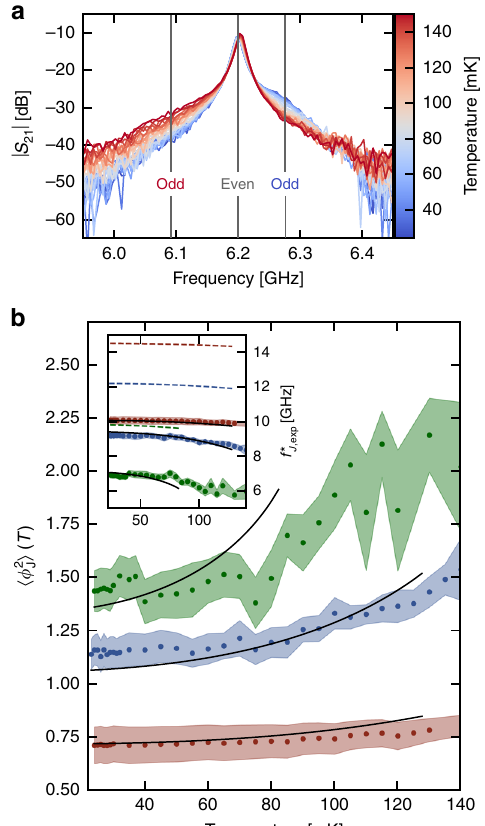
Fig. 3 Temperature-induced renormalization. a Zoom on a even – odd pair of transmission peaks for sample A at temperature ranging from 23 to 150 mK. The even mode (gray) does not move while the odd mode (blue is at 25 mK, red at 130 mK) shifts down in frequency when warming up, showing a downward renormalization of the junction frequency ω (cid:5) . b ZPF of the J i as a function of the temperature for three samples (A, B, small junction h ϕ 2 J and C ranging from dark to light blue), extracted from Eq. (2). ZPF are = E stronger in sample A, which is associated to a smaller ratio E (large J ; bare c nonlinearity). The measured quantum to classical crossover is in good agreement with theory (full lines). The inset displays the corresponding ¼ ω (cid:5) = 2 π of the three samples. The full renormalized junction frequency f (cid:5) J J lines are the SCHA predictions while the dashed lines represent what would be the temperature evolution of these frequencies if ZPF were omitted from h ϕ 2 i , using the same values of E J ; J surrounding circuitry. Note that we de fi ne E (cid:5) in terms of L (cid:5) , and J J not in terms of the DC critical current as is done in for instance 23 .